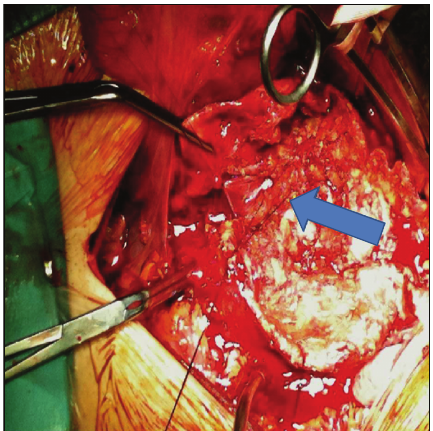
Figure 3: Abdominal CTA revealing a large 9.8 cm AAA with communication between the aorta and the IVC, without evidence of retroperitoneal